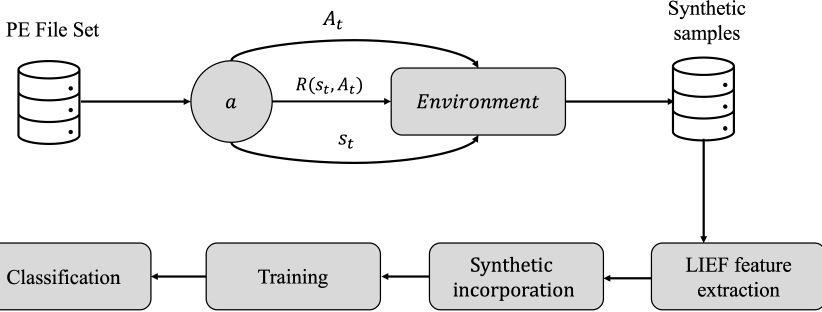
Figure 2. Proposed framework for the generation of synthetic binary samples in PE format using